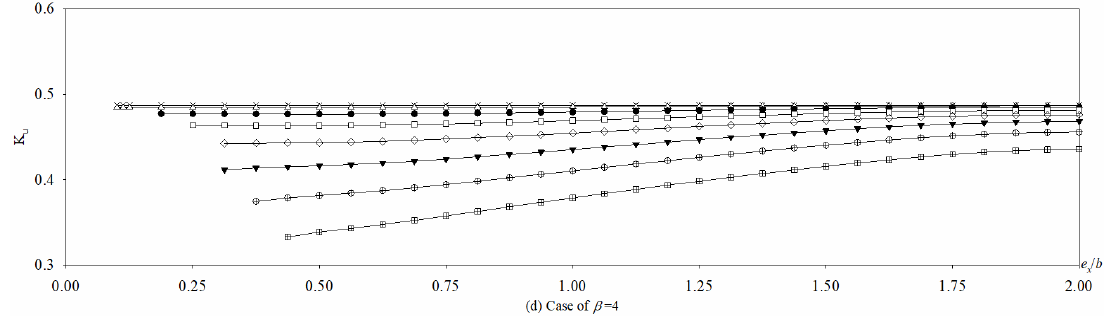
Figure 17. K u vs. e x / b for perforated rectangular plate ( β = 1, 2, 3, 4) with the BCs of 3S1F.